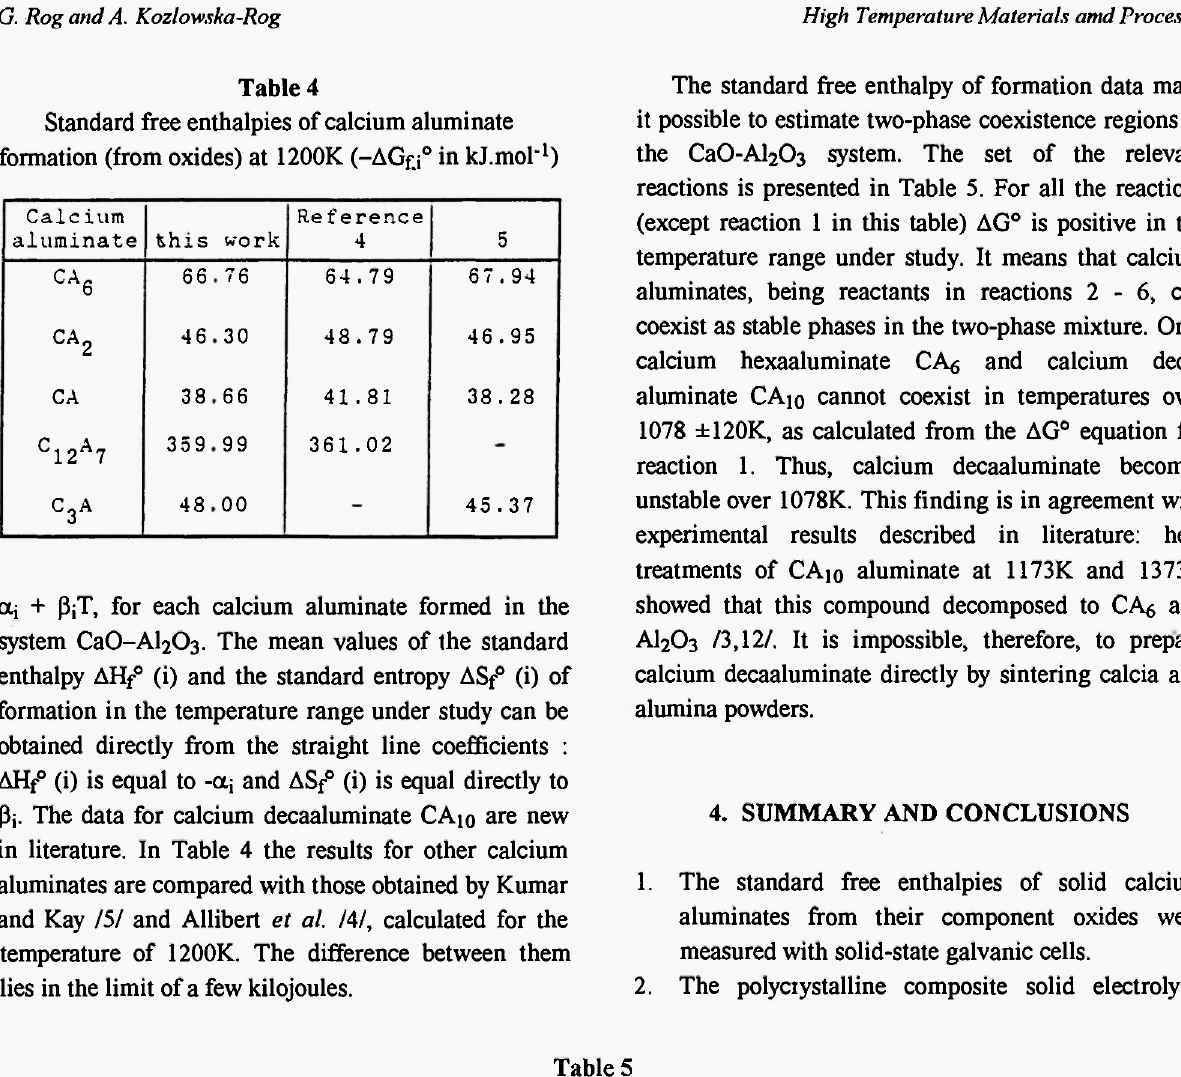
Standard free enthalpy changes for the reactions of calcium aluminate decomposition, as functions of temperature: A G;° =A\ +